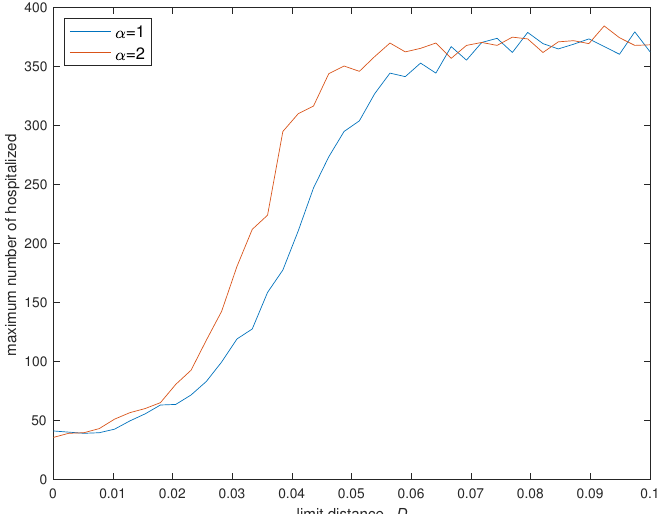
Figure 7. Variation of the maximum number of hospitalized ( I 2 ) versus the social neighborhood D for α = { 1,2 } ( N = 500, n i = 50, δ = 0.1, p 1 = 0.1, p 2 = 0.9, p 3 = 0.7, p 4 = 0.05, p 5 = 0.02 and N h → ∞